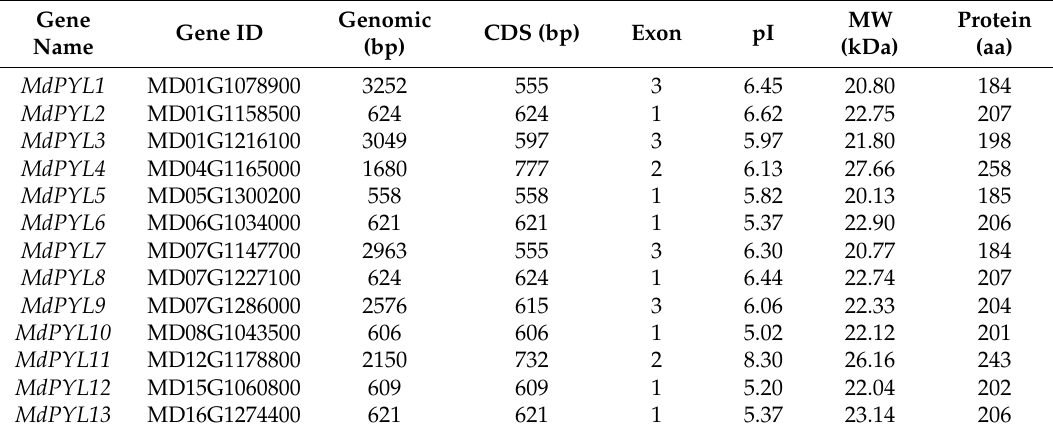
Figure 1. Chromosomal distribution and localization of MdPYL s. Only nine chromosomes contained MdPYL s are represented in this figure. The chromosome names are shown at the top of each chromosome. The chromosome scale is in millions of bases (Mb) on the left. Table 1. Basic informations of 13 MdPYLs identified in